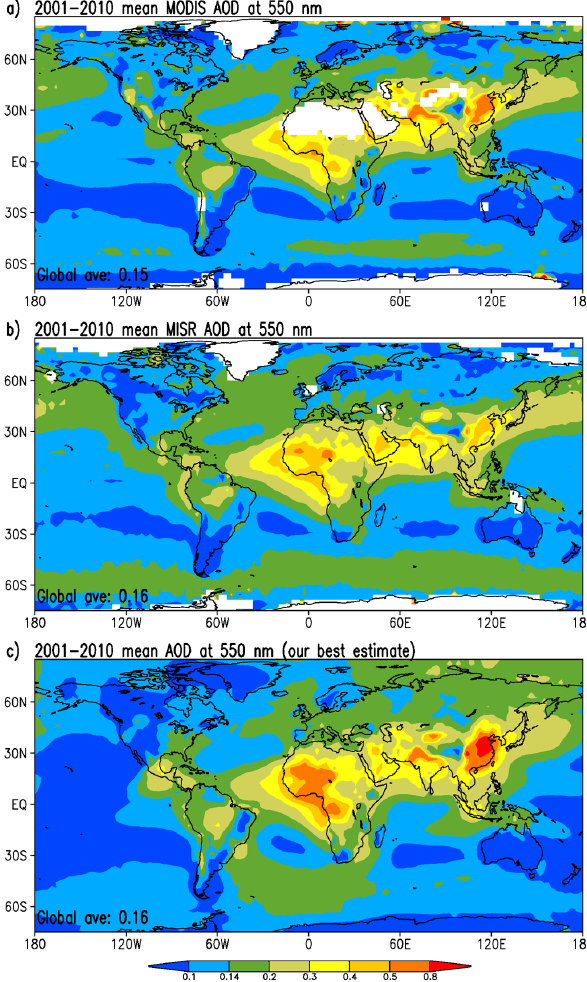
Fig. 2. Decadal mean AOD on the T42 resolution. Our best esti- mates, as shown in (c), integrate AERONET, MISR, MODIS, and GOCART